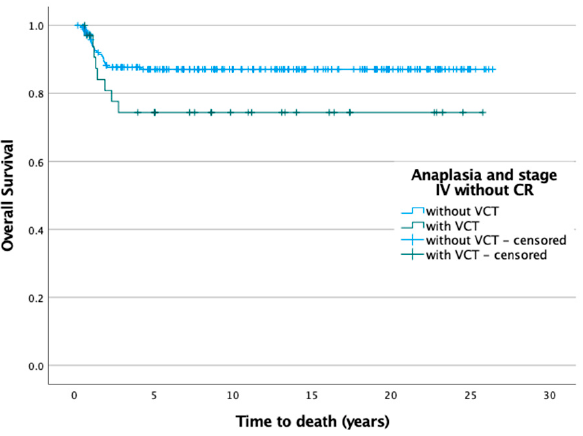
Figure 3. Overall survival of patients with diffuse anaplasia and no remission of metastasis after preoperative chemotherapy depending on VCT.